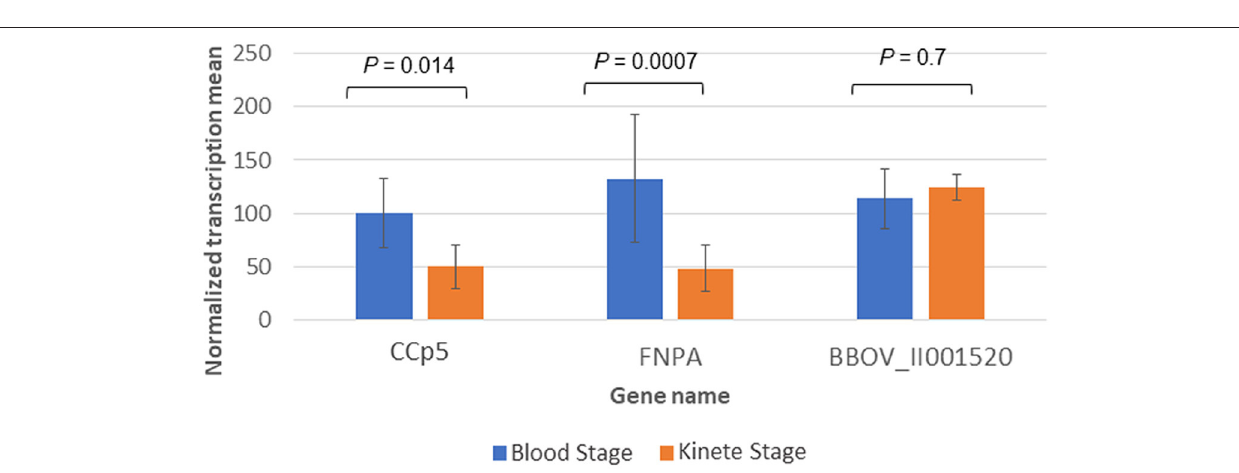
FIGURE 5 | Differential expression of CCp5 and FNPA between B. bovis blood and kinete stages, respectively in the RNA-Seq datasets. The 26S proteasome non-ATPase gene (BBOV_II001520) was used as a control gene for blood and kinete